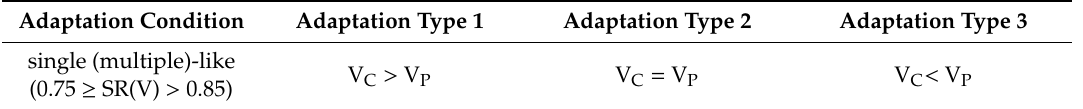
Table 5. Case adaptation-analysis of a single type of